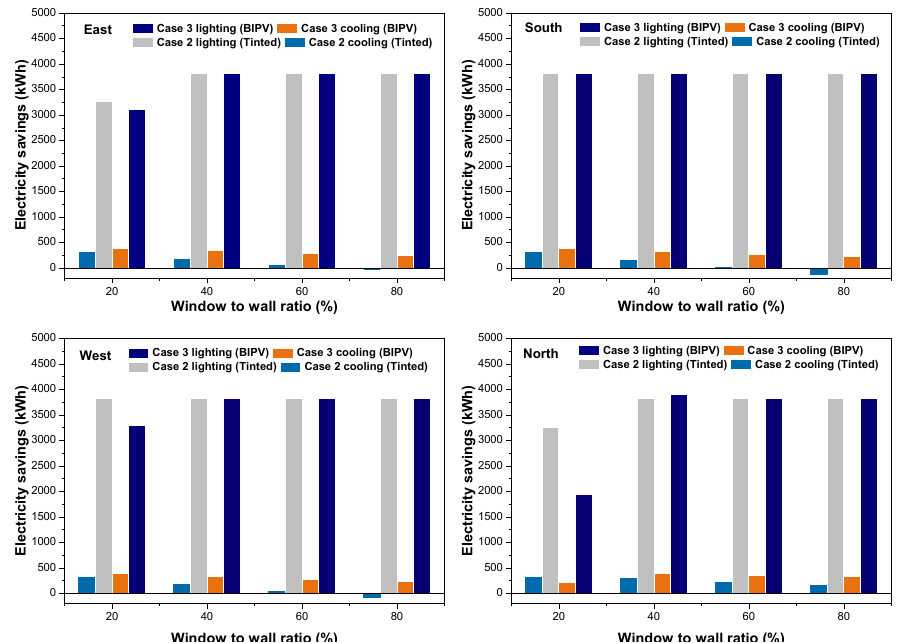
Figure 16. Cooling- and daylight-linked control-lighting savings for the different cases.